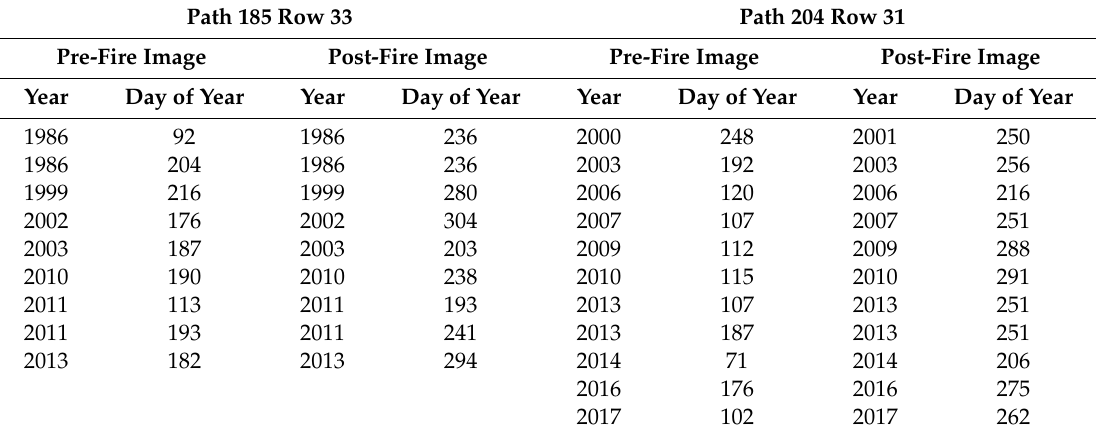
Table 1. Acquisition dates of pairs of Landsat images used for the algorithm development. Path 185 Row 33 Path 204 Row 31 Pre-Fire Image Post-Fire Image Pre-Fire Image Post-Fire